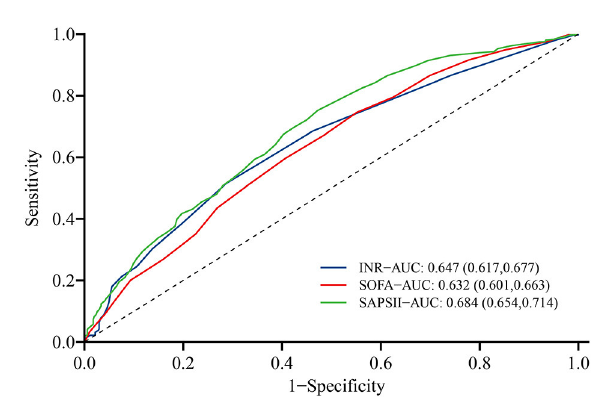
FIGURE5 Receiver operating characteristic curve of INR (blue), SOFA score (green), and SAPSII score (red) for predicting 1-year all-cause mortality of post-CA patients. CA, cardiac arrest; SOFA, the sequential organ failure assessment; SAPSII, the simplified acute physiology score